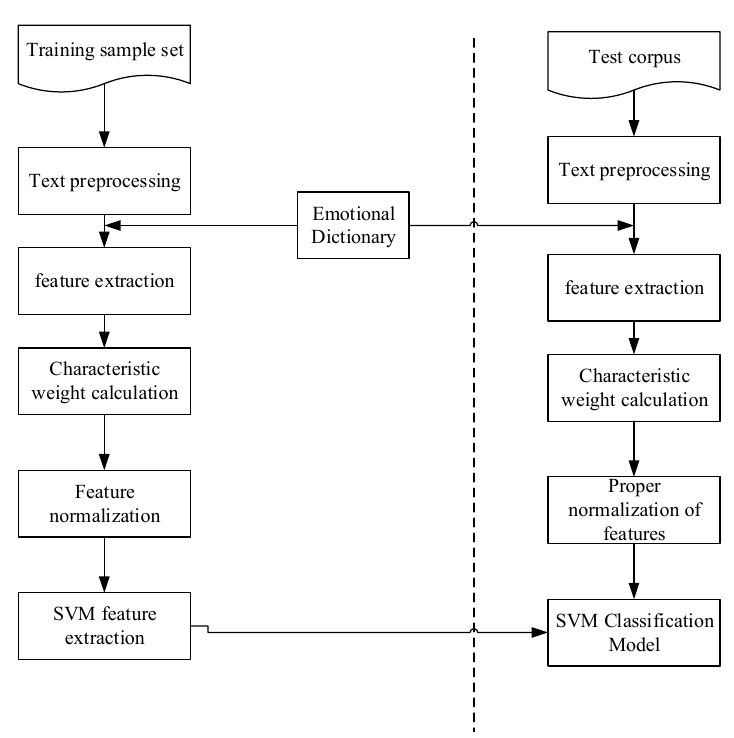
Figure 6. Flow chart of Support Vector Machine (SVM) algorithm for emotional classification.